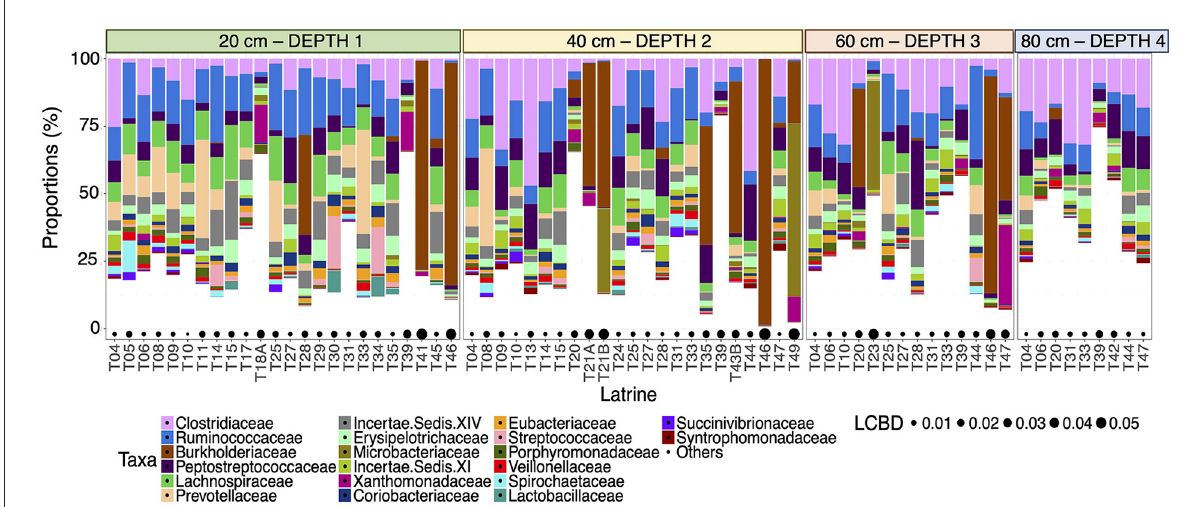
FIGURE1 Stacked bar plot of the 20 most proportionally abundant family-level taxa (on the y-axis as percentage relative proportion) for all the samples from individual pit latrines (labeled T##) ordered by depth from 20 (Depth 1), 40 (Depth 2), 60 (Depth 3), and 80cm (Depth 4) [left to right on the x-axis]. Local Contributions to Beta Diversity (LCBD) values are drawn as bubbles below. A higher LCBD value suggests the community is different from the average community profile (indicating